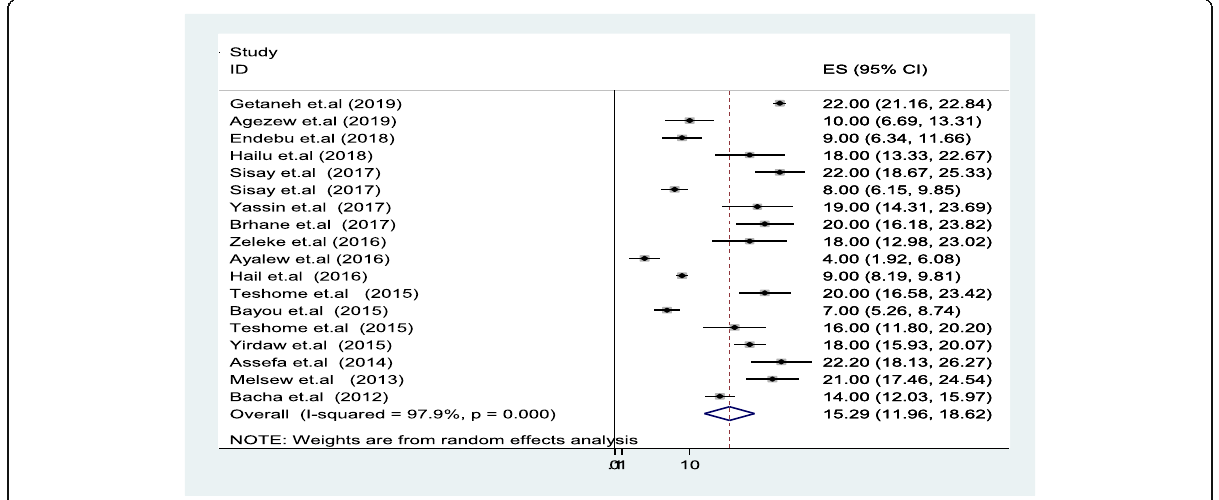
Fig. 2 Forest plot of pooled prevalence on first line treatment failure in